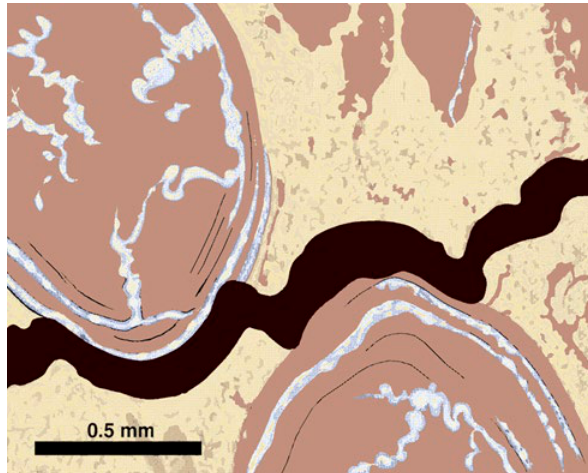
Figure 81. A stylolitic veinlet of magnetite cuts the margins of hematite oolites in a chert matrix at the Mary Ellen Mine, Biwabik, Lake Superior province. These hematite oolites have well developed syneresis shrinkage cracks filled with quartz which also extends into ‘saddle reefs’ or layers within the rim zones. The remobilised silica gel precursor has been intruded (ptygmatically in places). A ptyg- matic magnetite veinlet cutting soft precursor chert and hematite oolites is very clear evidence for viscosity dependent on the rate of shear (flow). Recorded by Lougheed 4 (1983, p.